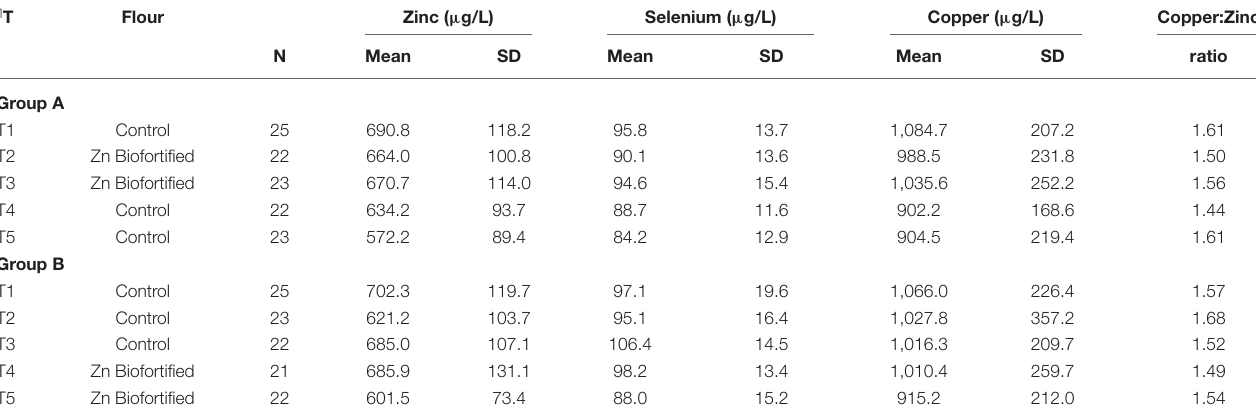
TABLE 4 | Plasma Zinc, selenium, and copper concentrations ( µ g/L) and copper:zinc ratio for groups A and B at each